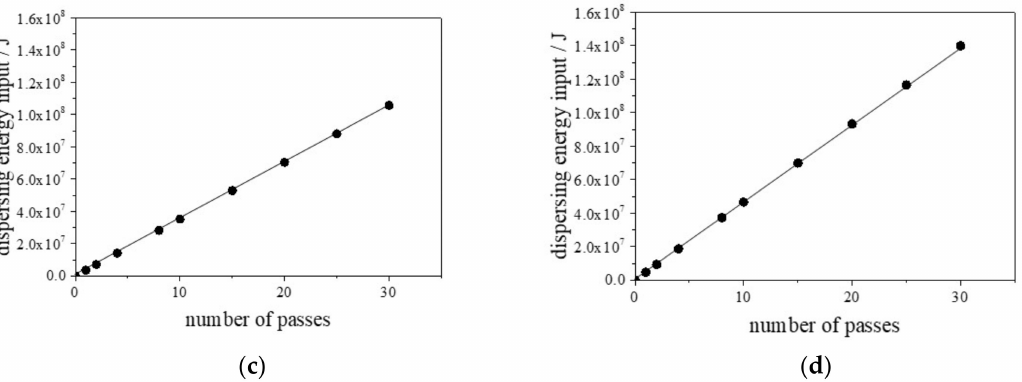
Figure 1. Plots of the calculated dispersing energy input as a function of the number of passes in the wet-jet milling system. The values of the dispersing energy input were evaluated at four different pressures in the narrow channel and pass time in the wet-jet milling system: ( a ) 80 MPa, ( b ) 120 MPa, ( c ) 180 MPa, and ( d ) 240 MPa, respectively.